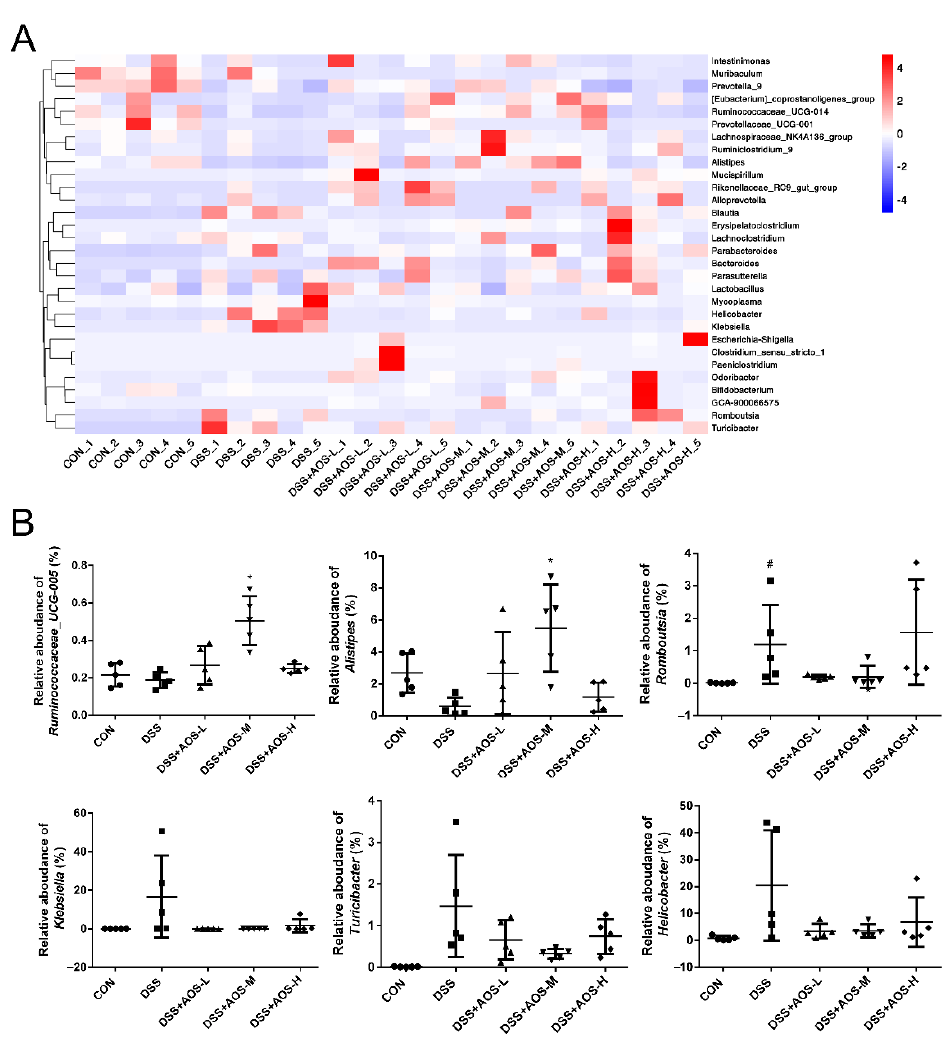
Figure 9. Effects AOS on the gut microbial composition of colonic contents at genus level. ( A ) Heat map analysis of gut microbial composition at genus level. ( B ) Relative abundance analysis of gut microbiota at genus level. * p < 0.05 vs. DSS group; # p < 0.05 vs. Control group; n = 5.